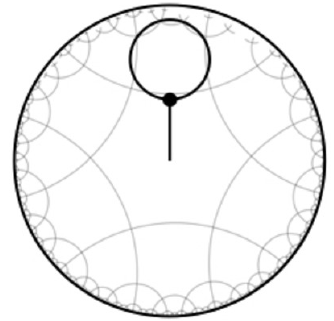
Figure 5. Scalar one-point tadpole diagram with o(cid:11)-shell external leg, generated by the cubic vertex (2.94)